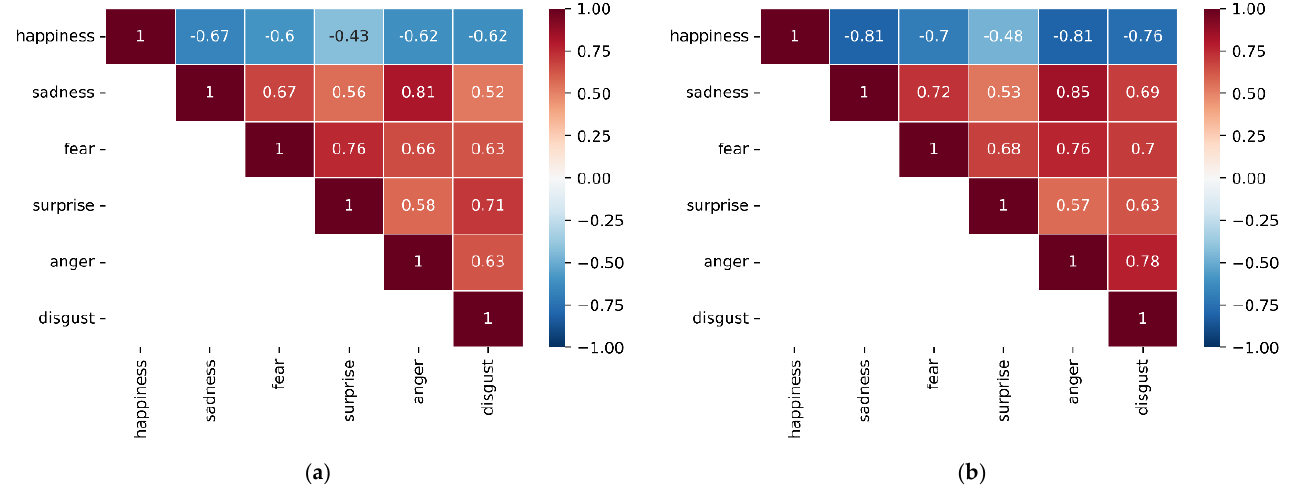
Figure 6. Correlations between 6 emotion norms (happiness, fear, sadness, surprise, anger, disgust) in the NAPS BE dataset: ( a ) Pearson correlation coefficient matrix ( r ); ( b ) Spearman’s rank matrix ( r s ).